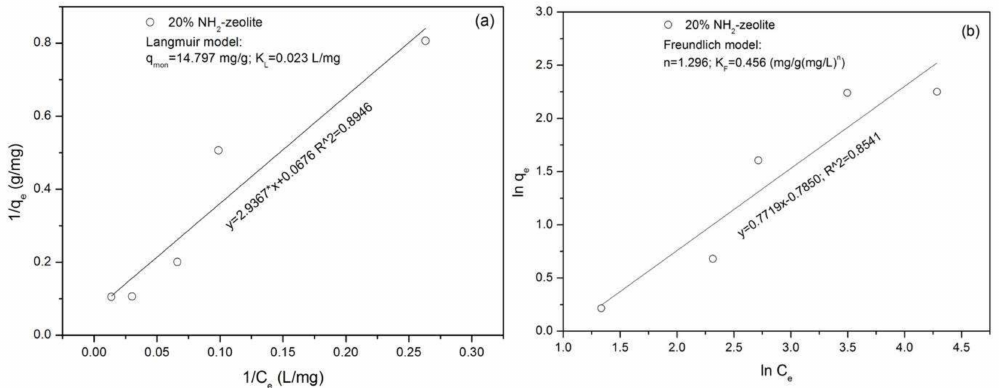
Figure 10. Langmuir ( a ) and Freundlich ( b ) plots for adsorption of chromate ions onto the amino functionalized zeolite sample.